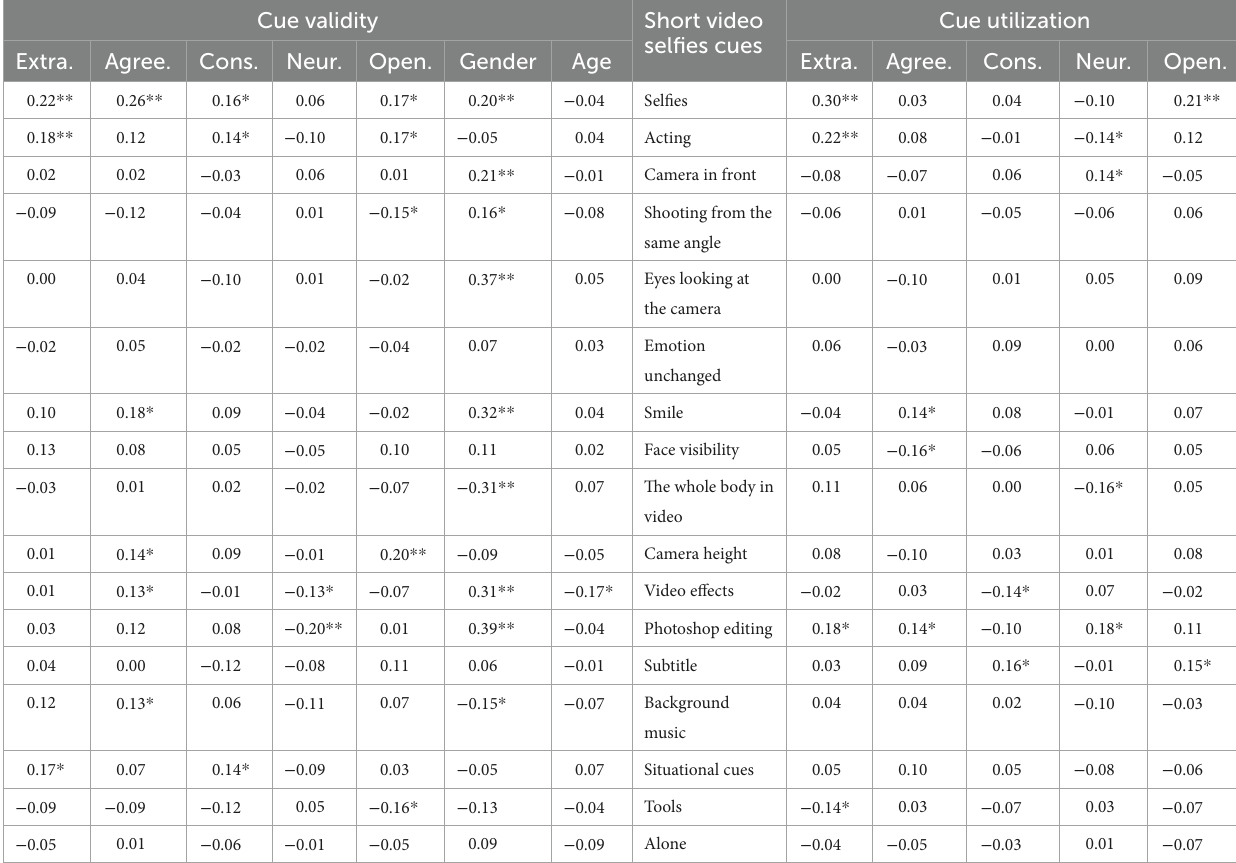
TABLE 2 The lens model analysis: Cue-validity (Cue-utilization)